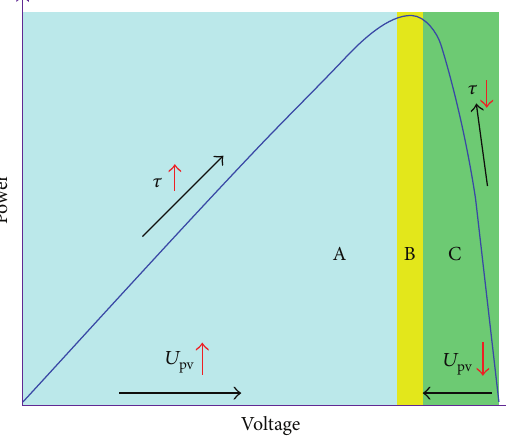
Figure 7: Three different regions of an illustrative P - V